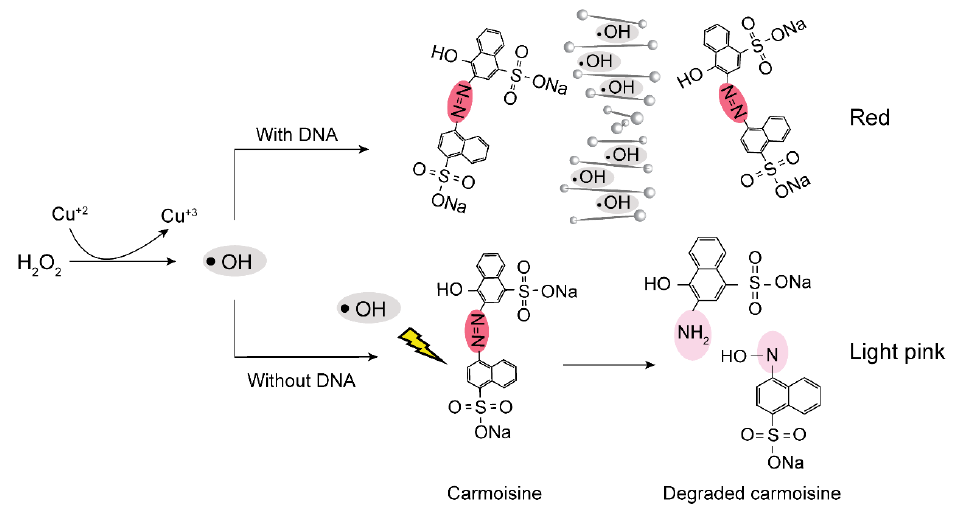
Figure 1. Schematic demonstrating the mechanism for the colorimetric detection of RT-LAMP am- plicons using carmoisine. amplicons using